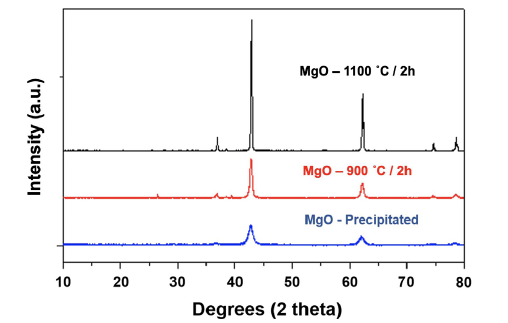
Figure 1. X-ray diffractograms of MgO powders in two conditions: precipitated and after calcination at different temperatures (900 ºC and 1100 ºC, for 2 h).